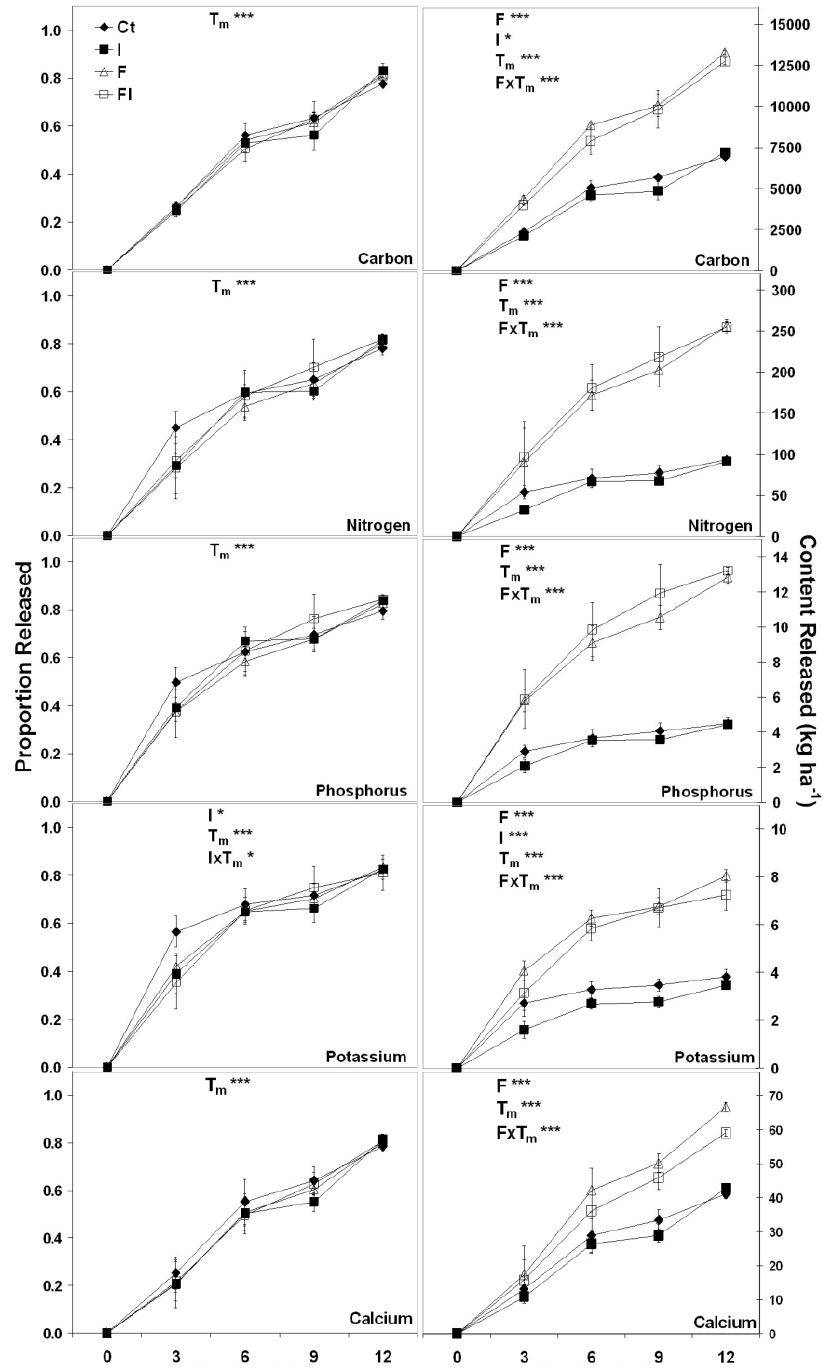
Figure 3. Mean litterbag C, N, P, K, and Ca proportion (left panels) and content (right panels) released from forest floor Oi and Oe horizon material from May 2009 to May 2010 for the simulated forest floor decomposition experiment. Error bars represent 1 standard deviation. Main and interaction effects were significant at p < 0.05 ( * ), 0.001 ( ** ), and 0.0001 ( *** ). Effects: fertilization (F), irrigation (I), and time (T m